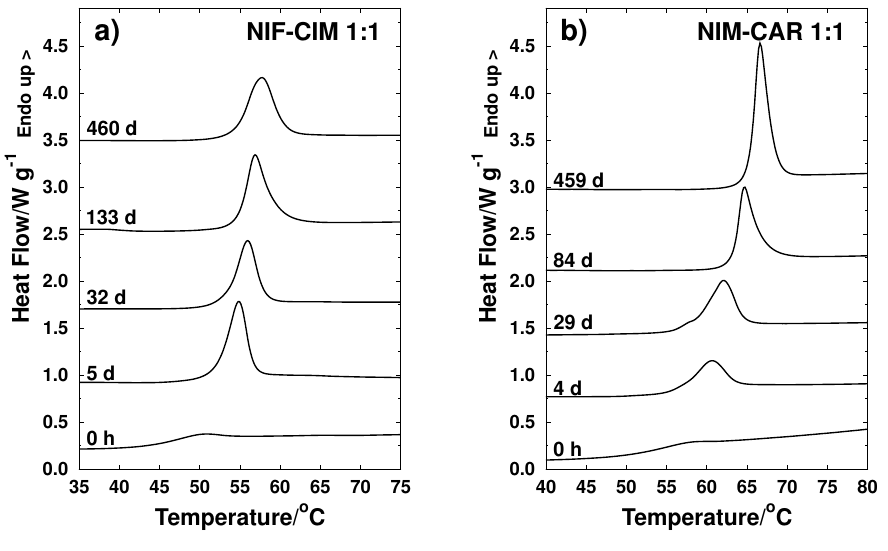
Figure 6. Behavior of glass transition temperature as a function of storage time (days) for amorphous binary systems: ( a ) NIF-CIM and ( b ) NIM-CAR. For both systems, the molar ratio is